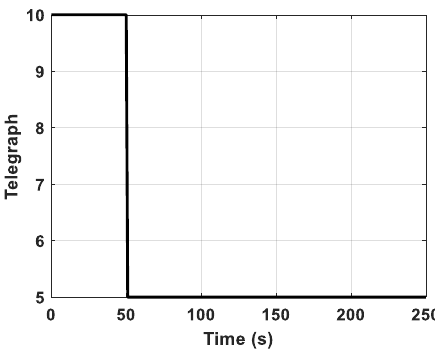
Figure 17. Ship speed time history.